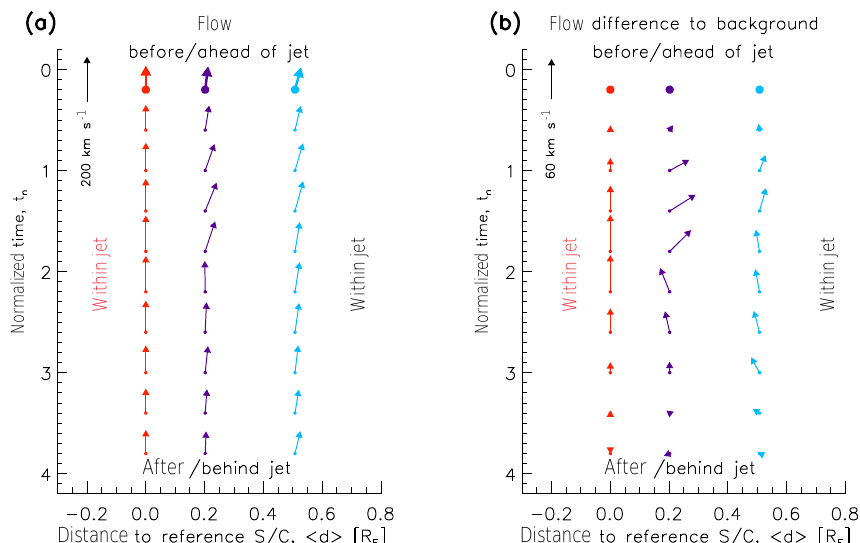
Figure 3. Visualization of velocities depicted in Fig. 2; cases where second spacecraft observed jets. Left panel (a) : arrows show median velocity components v (cid:107) (upwards) and (cid:49)v ⊥ (to the right) corresponding to different normalized times t n . Red arrows are based on reference spacecraft measurements. Purple and blue arrows show median v (cid:107) and (cid:49)v ⊥ for second spacecraft at two different distances (cid:104) d (cid:105) = 0 . 20 R E and (cid:104) d (cid:105) = 0 . 51 R E . Initial values pertaining to normalized times t n = 0 ... 0 . 4 are depicted by bold arrows/circles. Right panel (b) : derived from (a) by subtracting those initial flow values, i.e., the respective background flows in the